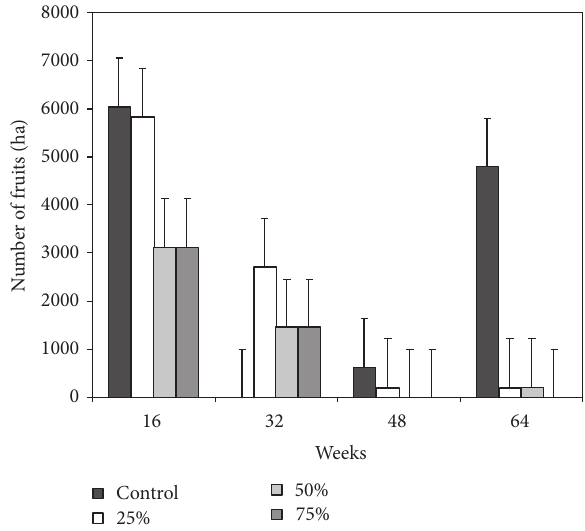
Figure 3: Total fruit number of T. daniellii in response to different foliage harvest intensities over 64